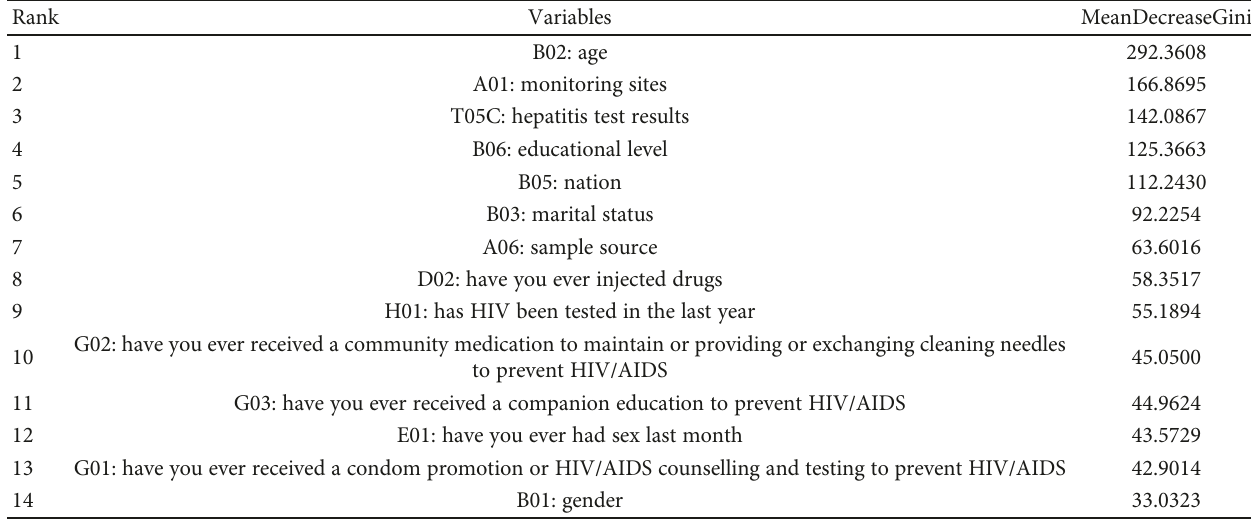
Table 8: Selection attributes used in models of IDU